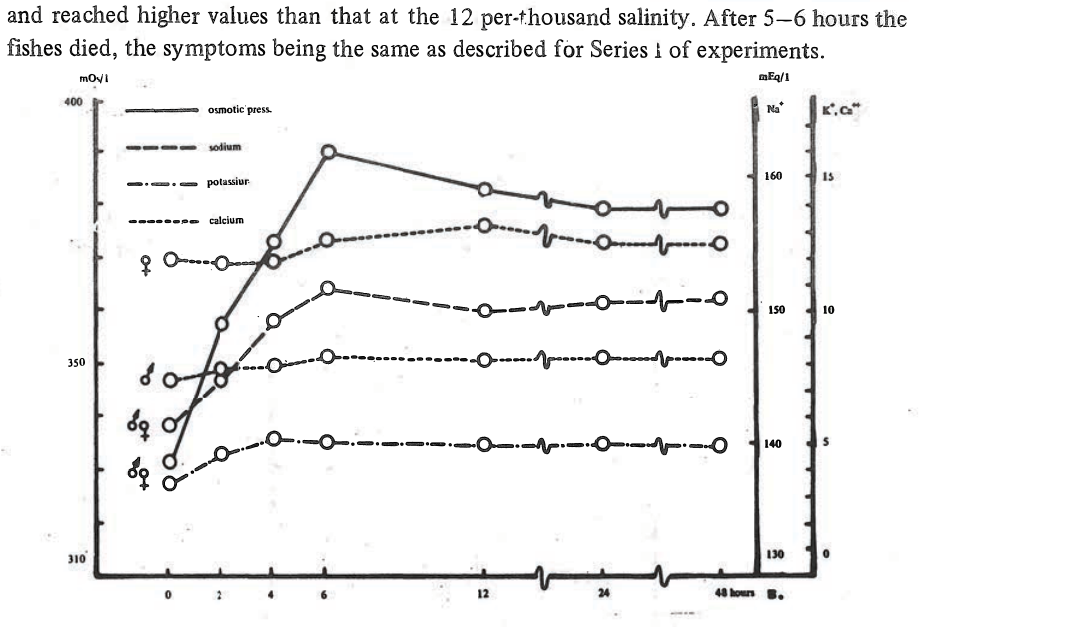
Fig. 5. Ionic-osmotic changes in pike blood serum at salini_ty of 12 per thousand (autumn 1969, 1970)